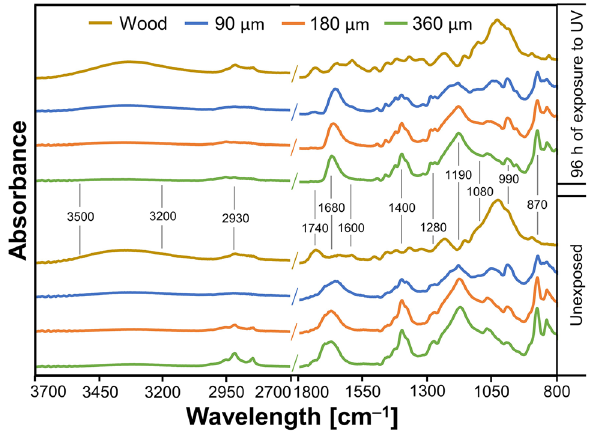
Figure 8. ATR-FTIR spectra of wood and coated samples in the wavelength region between (800 and 1800) cm ‒ 1 and region between (2700 and 3700) cm ‒ 1 , recorded before (unexposed) and after 96 h of exposure to UV light.